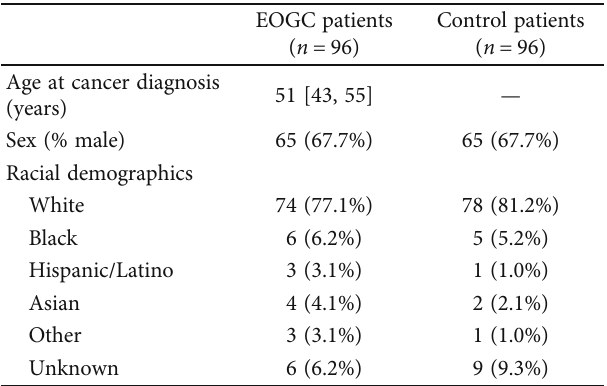
Table 1: Demographic characteristics of the EOGC patient and control patient